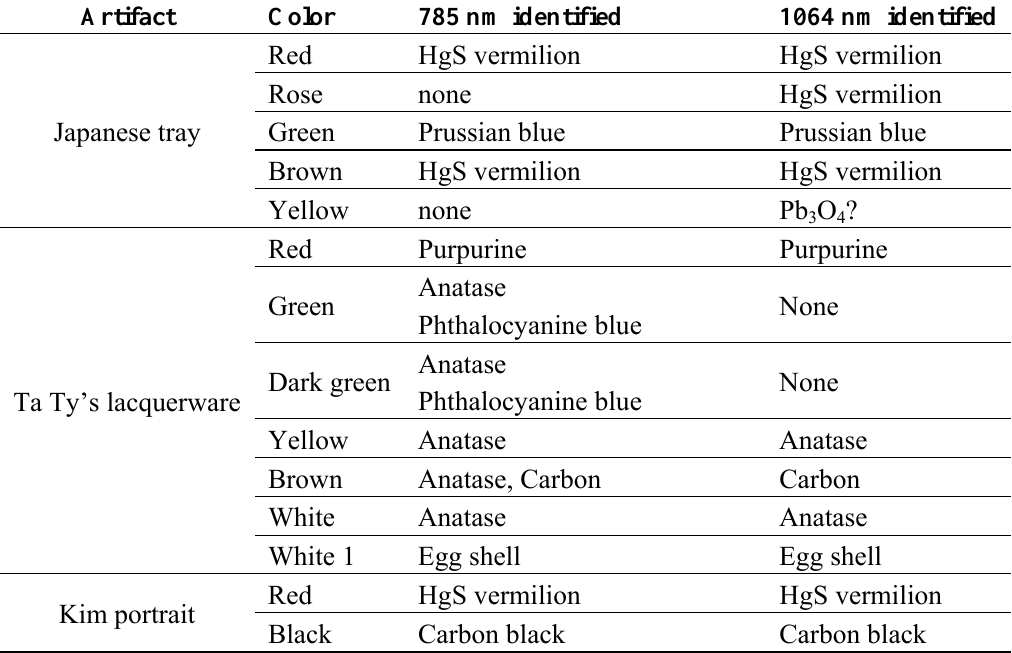
Table 1. Pigments Identified in the lacquerware presented in Figure